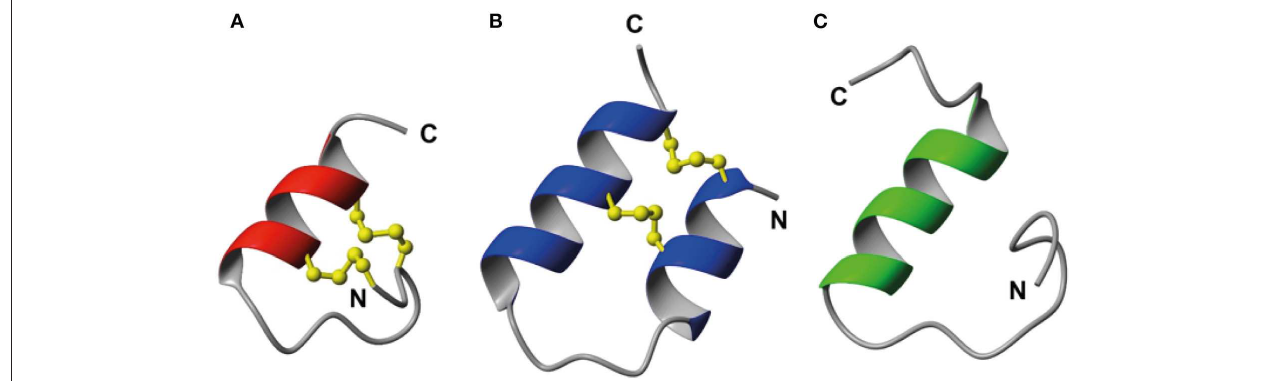
FIGURE 2 | Structural comparison of (A) apamin (red) and (B) VhTI (blue) with (C) the relaxin-3 B-chain (green). The apamin and VhTI scaffolds are stabilized by two disulfide bonds and include α -helices between residues 9–18 and 3–25, respectively.